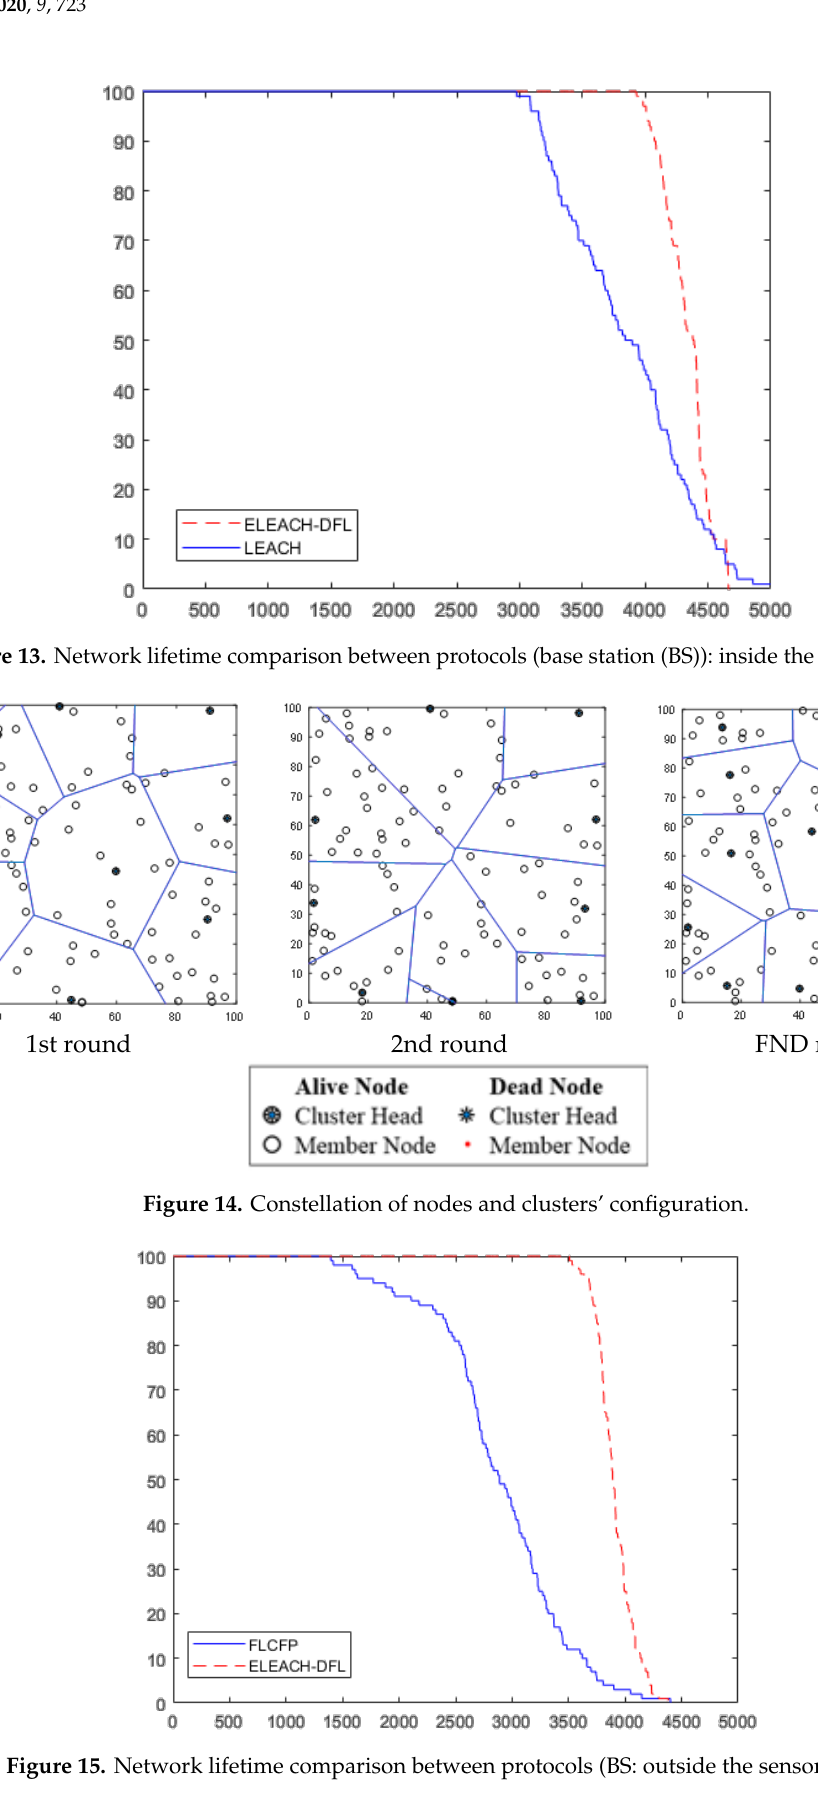
Figure 12. Constellation of nodes and clusters’ configuration.